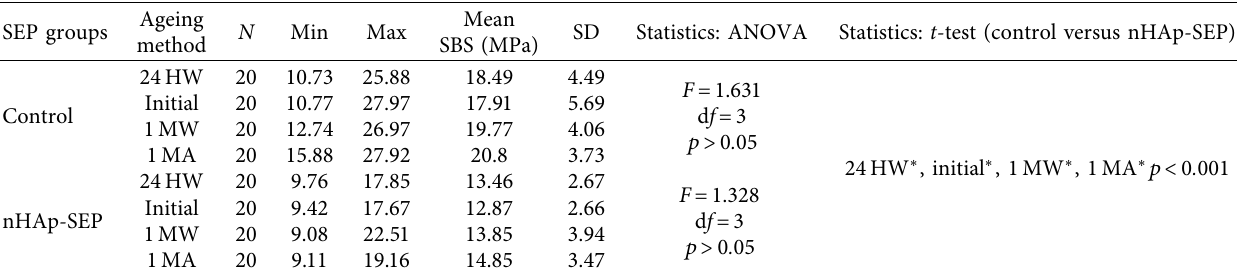
Table 4: Descriptive and inferential statistics of shear bond strengths (SBSs) of control and nHA-SEP groups of bracket debonding at 24h water storage (24HW), 30min (initial), one-month water storage (1MW), and one-month acid challenge (1MA).